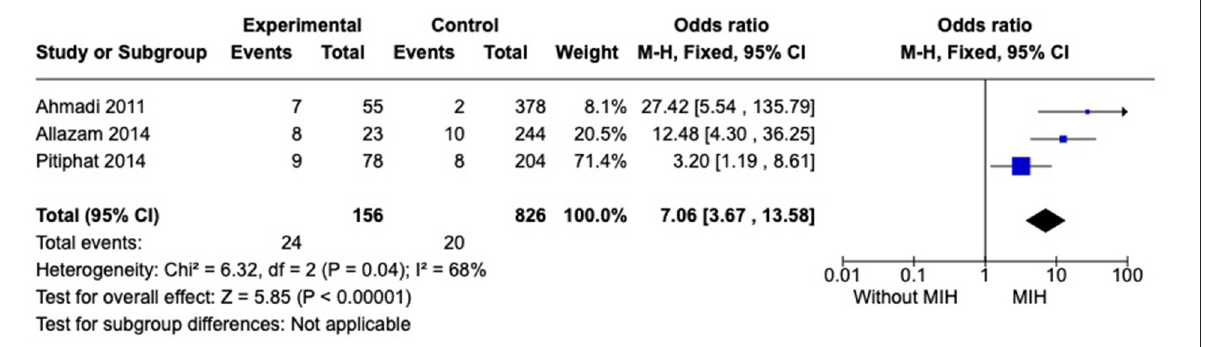
FIGURE2 Forest plot of meta-analysis for the prevalence of asthma among subjects with MIH. CI, confidence